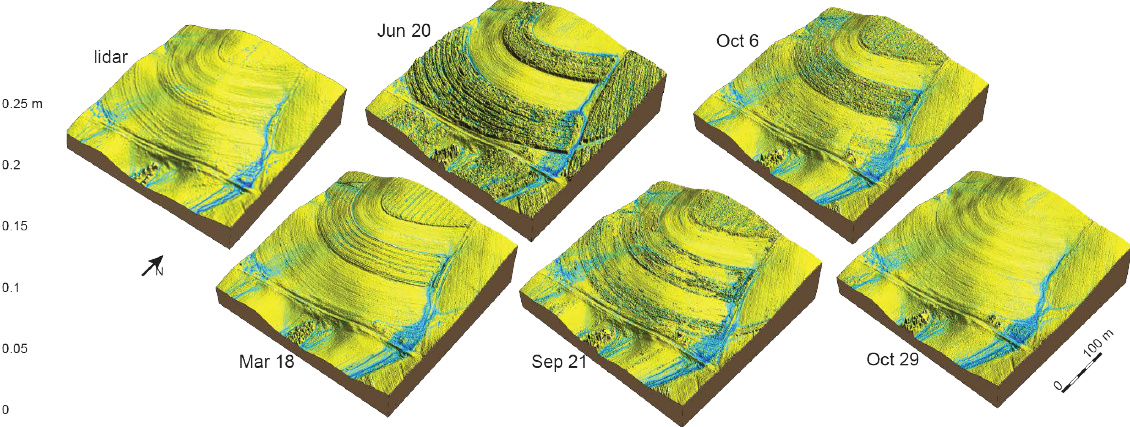
Figure 3: Overland flow pattern simulated for the lidar based DEM and DSMs based on the sUAS derived data in 5 flights in 2015